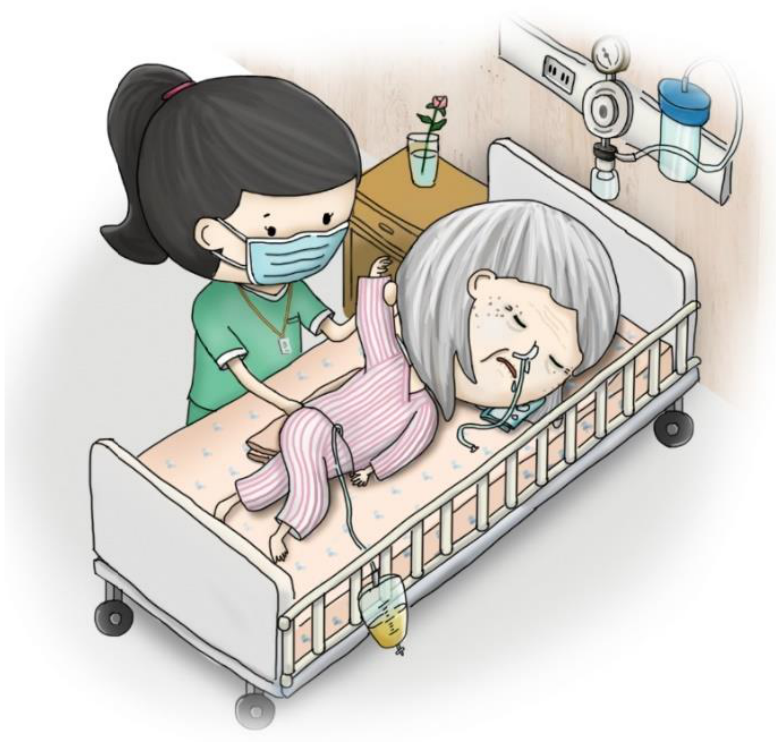
Figure 4. Coma with a slight chance of recovery.